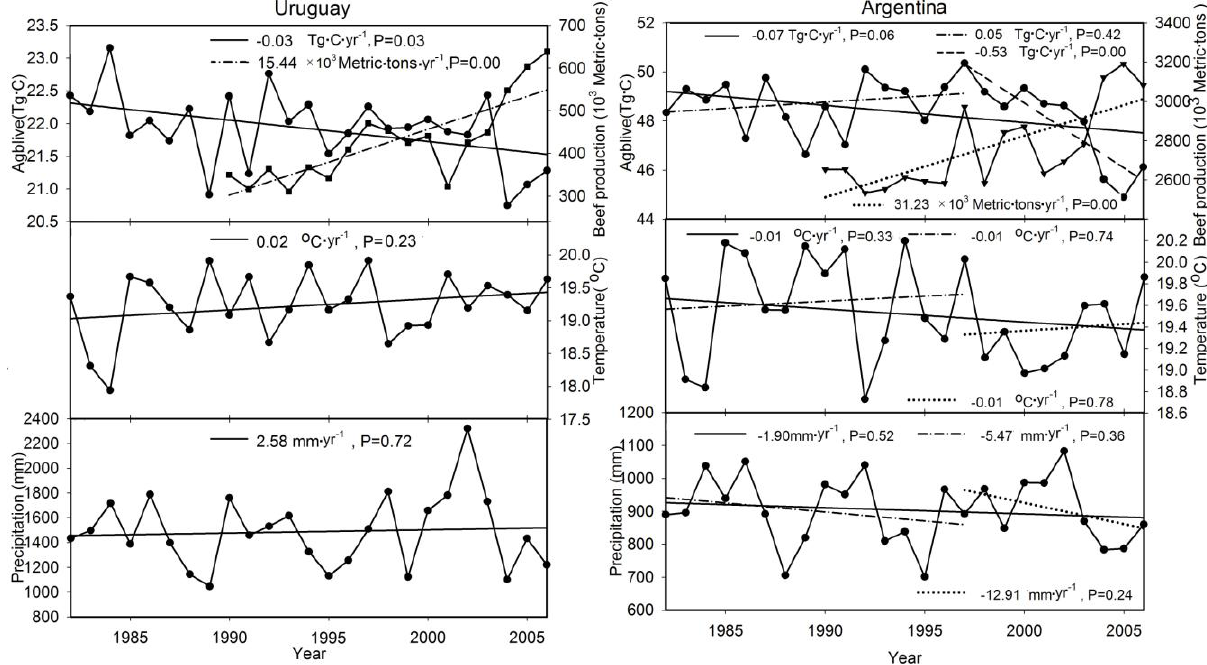
Figure 7. Interannual variability of total aboveground live biomass carbon stock (Tg·C·yr −1 ), beef production (Metric·tons·yr −1 ), annual mean temperature (°C·yr −1 ), and precipitation (mm·yr −1 ) in Uruguay ( Left ) and Argentina ( Right